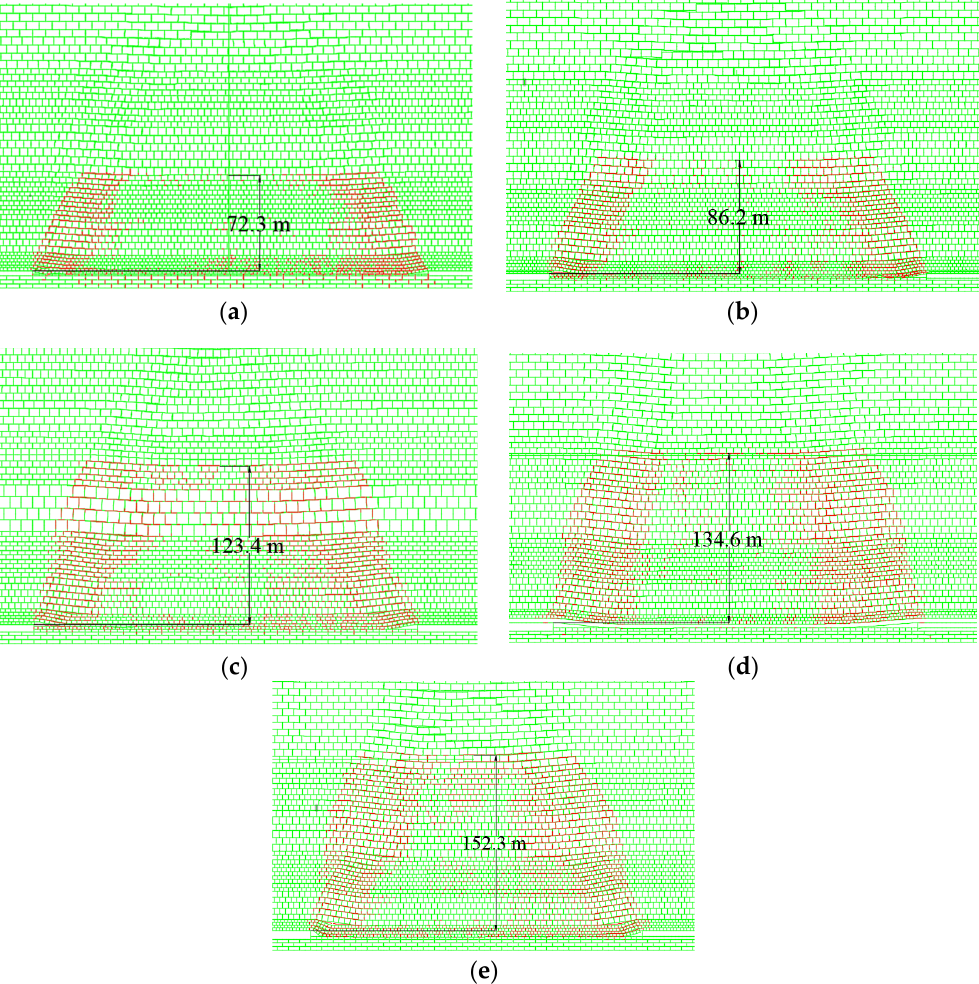
Figure 8. Development characteristics of overlying strata fractures under different mining height conditions. ( a ) Mining Height 4 m; ( b ) Mining Height 5 m; ( c ) Mining Height 6 m; ( d ) Mining Height 7 m; ( e ) Mining Height 8 m.